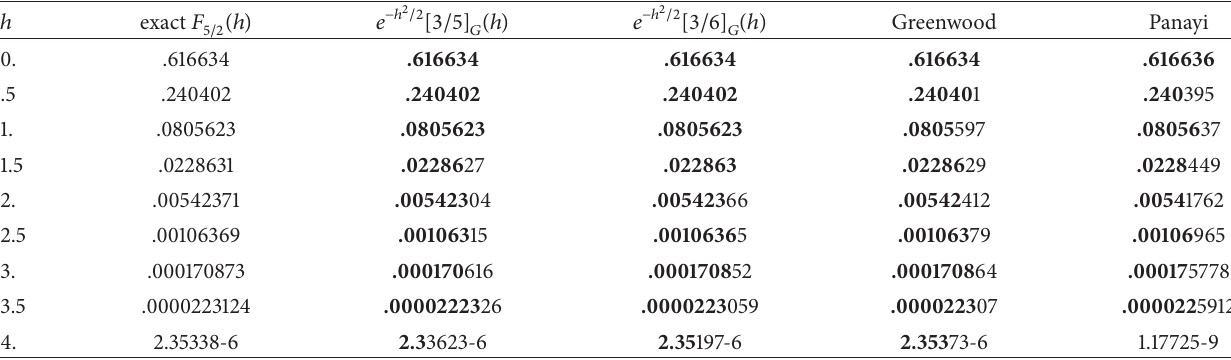
Table 3: Approximation of 𝐹 5/2 via one point ( ℎ = 0 ) Pad´e approximants of 𝐺 5/2 .